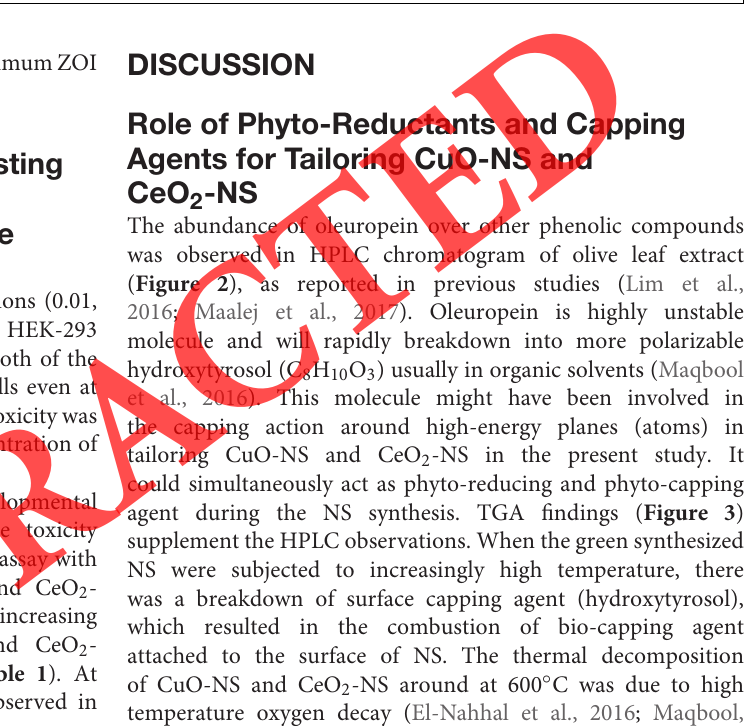
FIGURE 8 | Effect of green synthesized NS on HEK-293 cell viability.